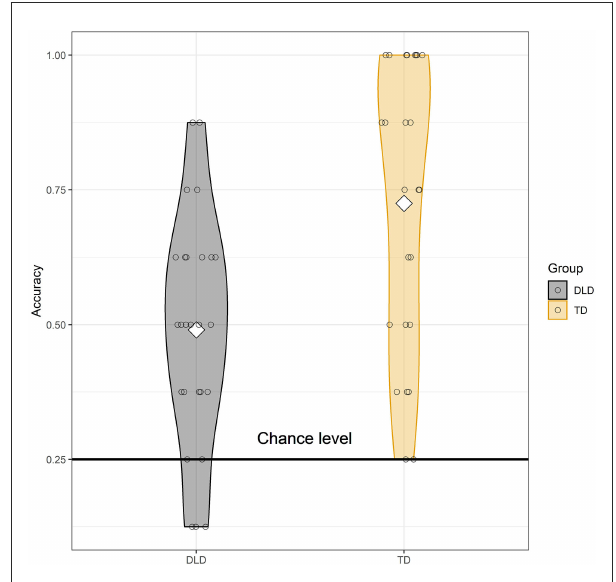
FIGURE3 Accuracy on the off-line test phase per Group.